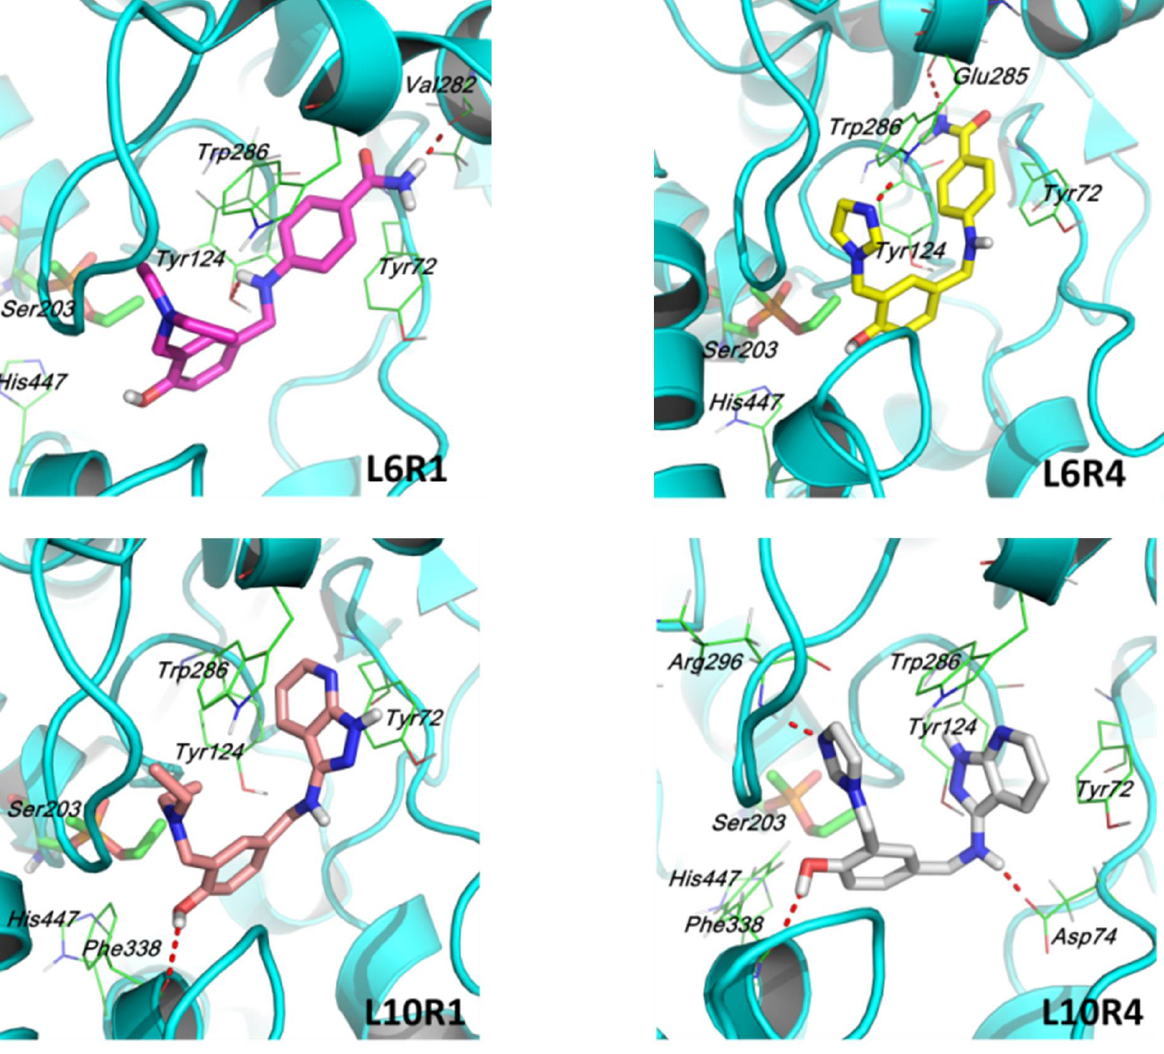
Figure 4. Docking conformations of molecules L6R1, L6R4, L10R1, and L10R4 in the active gorge of VX inhibited hAChE (pdb code: 6CQW). The key amino acid residues in the peripheral anionic site include Tyr72, Tyr124, Trp286, and Glu285; and in the active site include Ser203, Glu334, Tyr337, and His447. The docked conformations of the reactivators are depicted as a bond stick model and the key amino acid residues as a slim stick